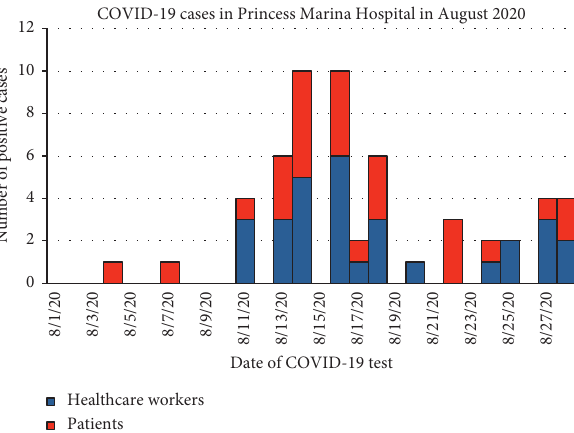
Figure 2: Epicurve for COVID-19 cases at Princess Marina